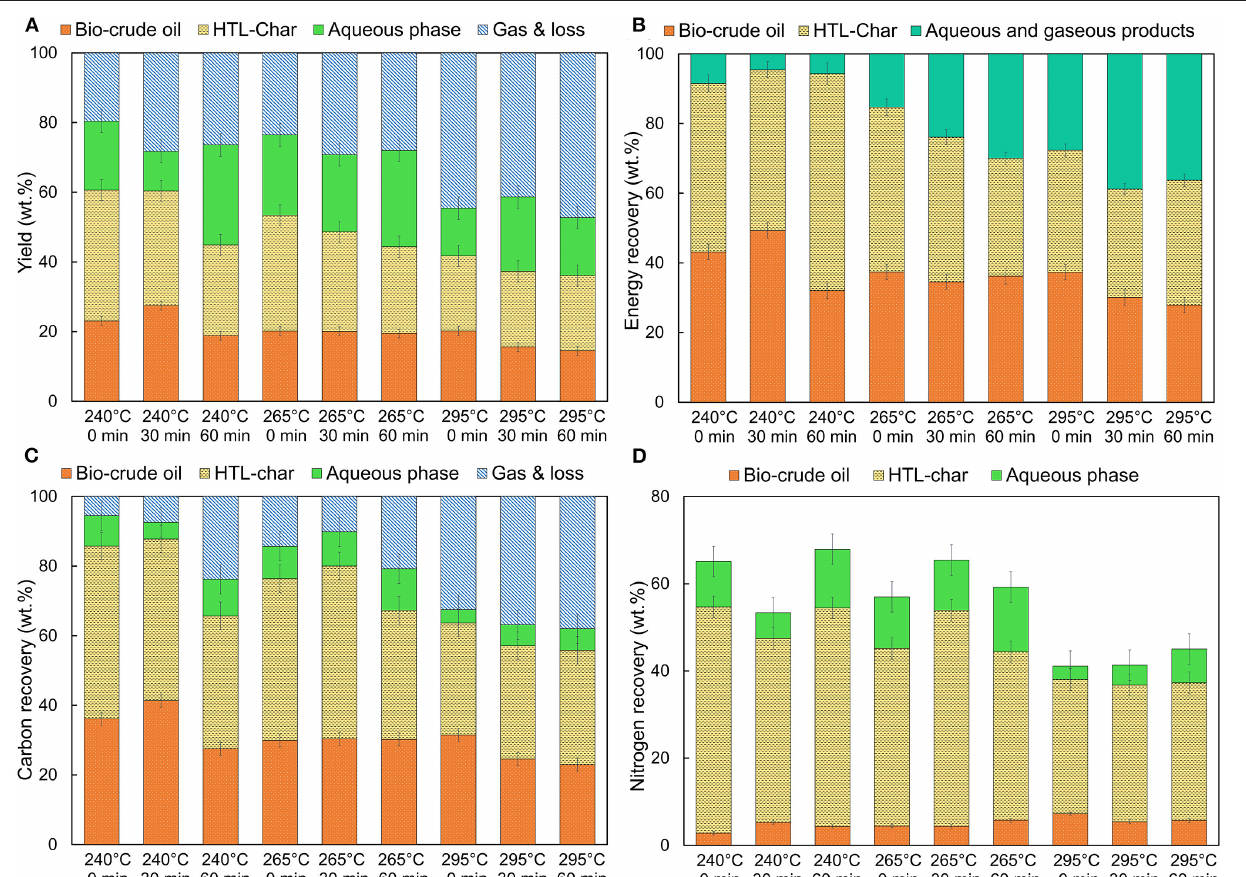
Frontiers in Sustainable Food Systems |